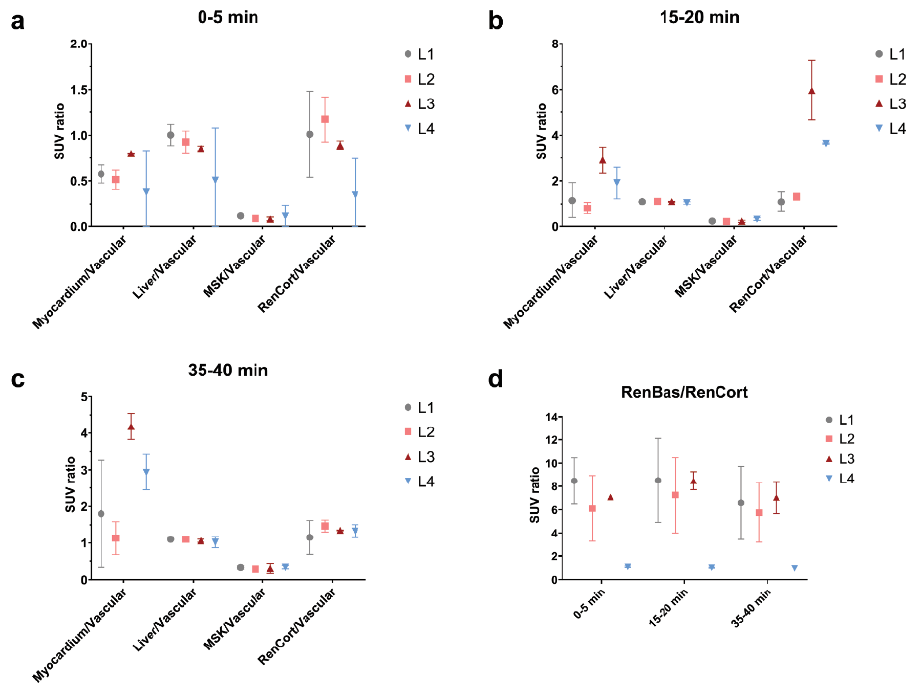
Figure 6. Static 18 F-FDG PET target organ SUV normalized to blood for TP1 ( a ), TP2 ( b ), and TP3 ( c ) and also as a proxy for renal output with kidney pelvis SUV normalized to kidney cortex ( d ).